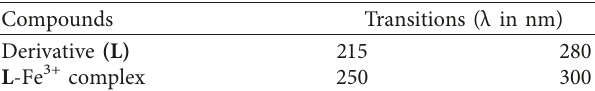
Figure 5: Job’s plot produced by mixing various equivalents of the derivative (L) (2.6